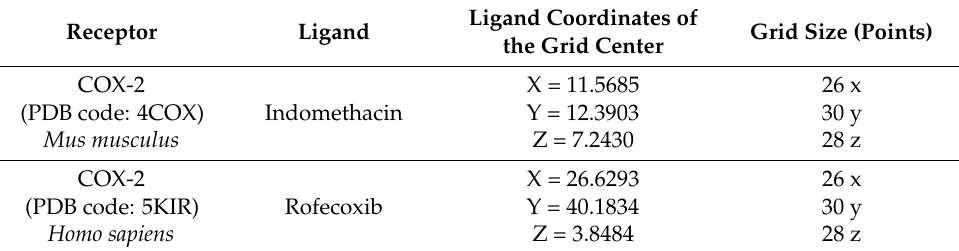
Table 4. Data from protocols used for molecular docking validation